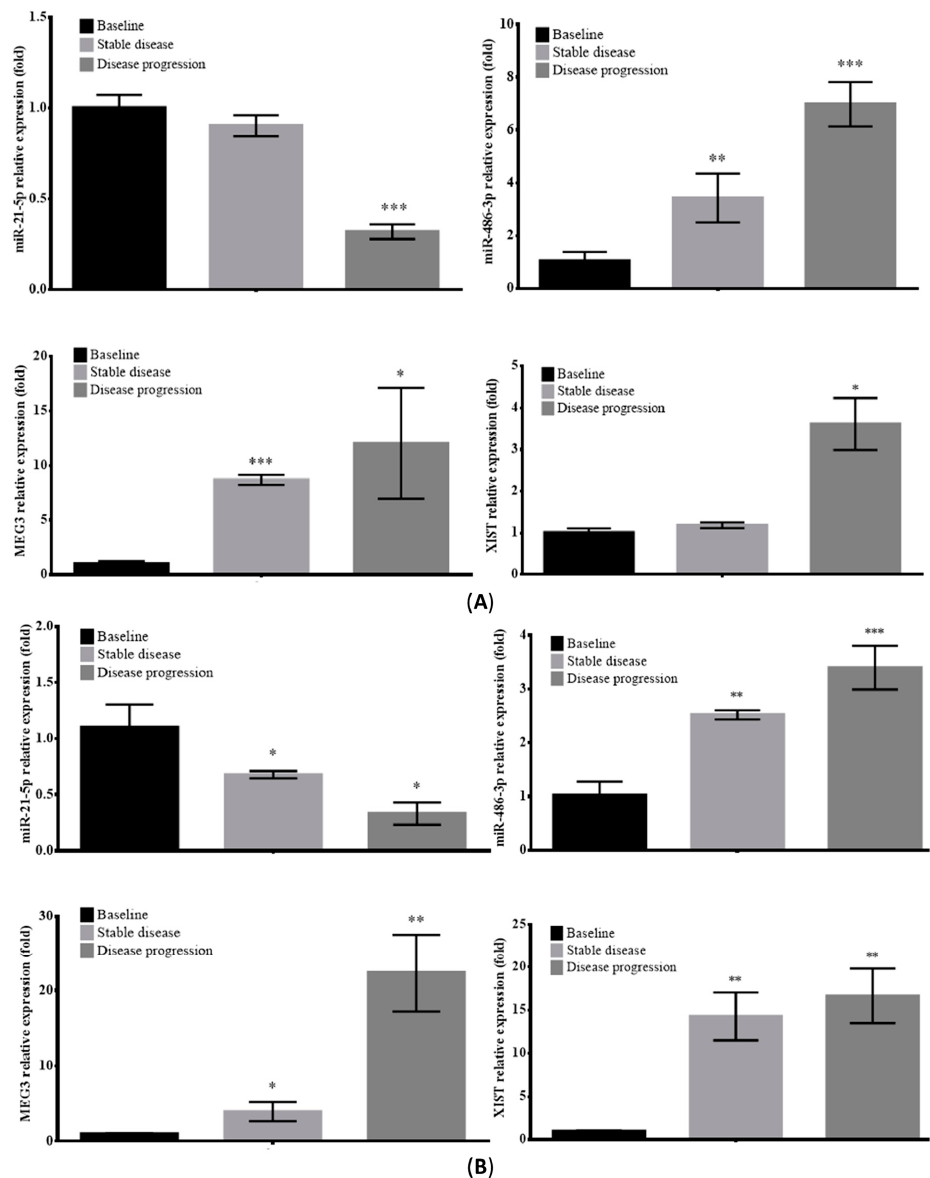
Figure 4. Expression changes of serum EV-associated miR-21-5p, miR-486-3p , MEG3 , and XIST in ALK -translocated NSCLC patients during crizotinib or ceritinib treatment. The relative expression levels of EV-associated miR-21-5p (upper left), miR-486-3p (upper right), MEG3 (lower left), and XIST (lower right) lncRNA in serial serum EV samples from ALK -translocated lung cancer patients treated with ( A ) crizotinib and with ( B ) ceritinib. The level of serum EV-associated miRNAs and lncRNA was determined by qPCR in the serial serum samples collected before treatment (Baseline), when disease was under control (Stable disease), and after disease progression (Disease progression). The values are presented as mean ± S.D. from technical triplicate experiments. * p < 0.05, ** p < 0.01, *** p < 0.001 vs.